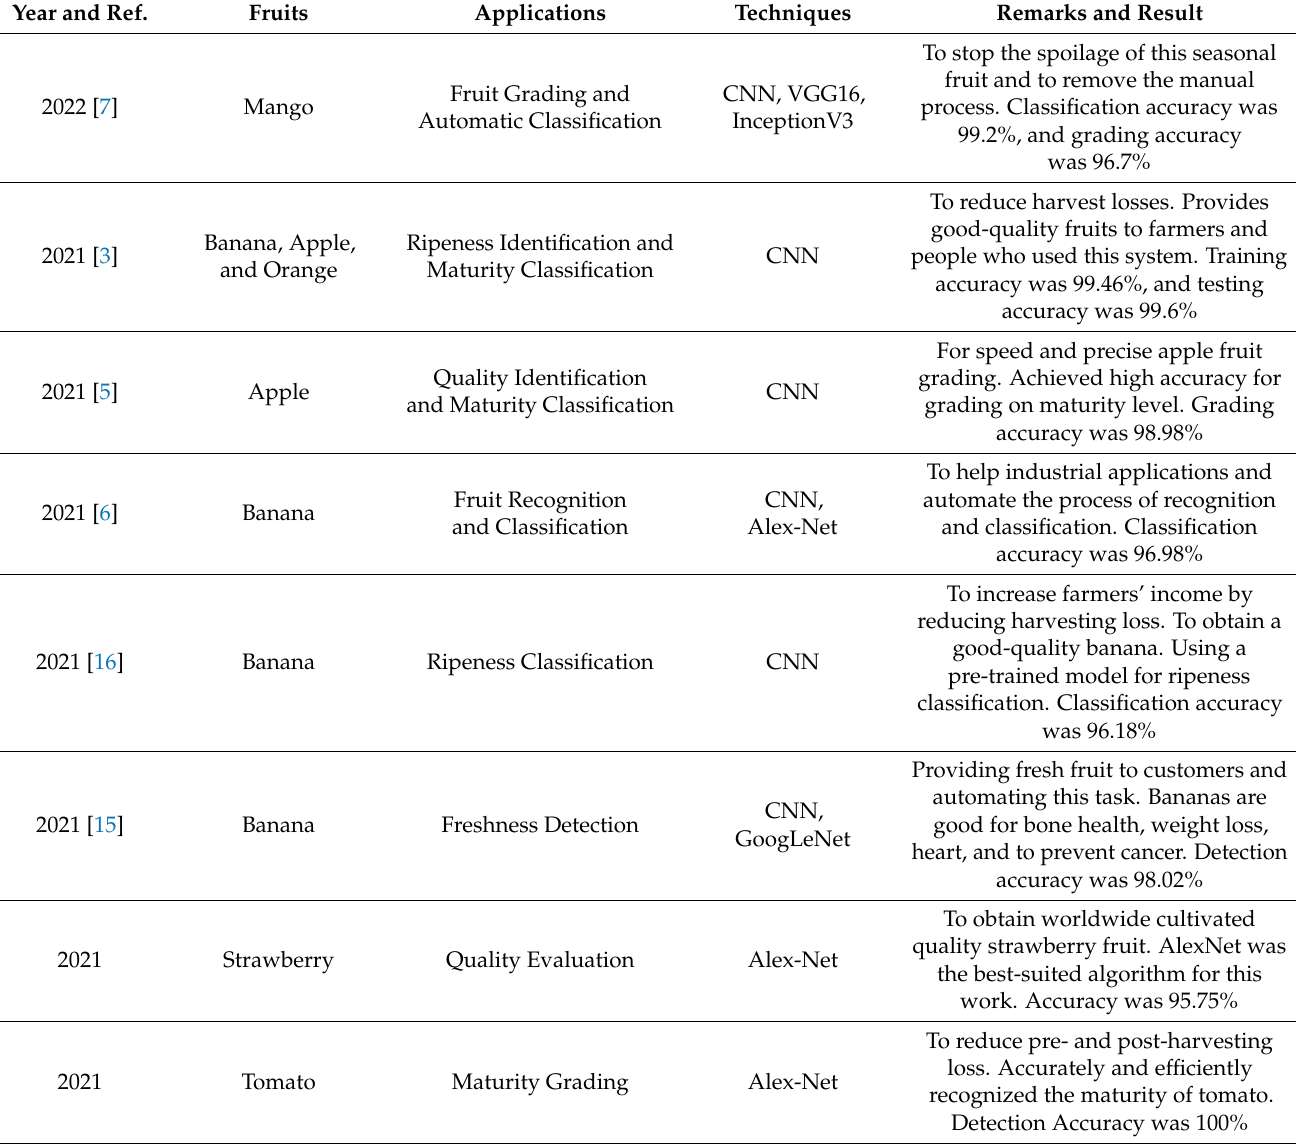
Table 1. Summary of already existing deep learning